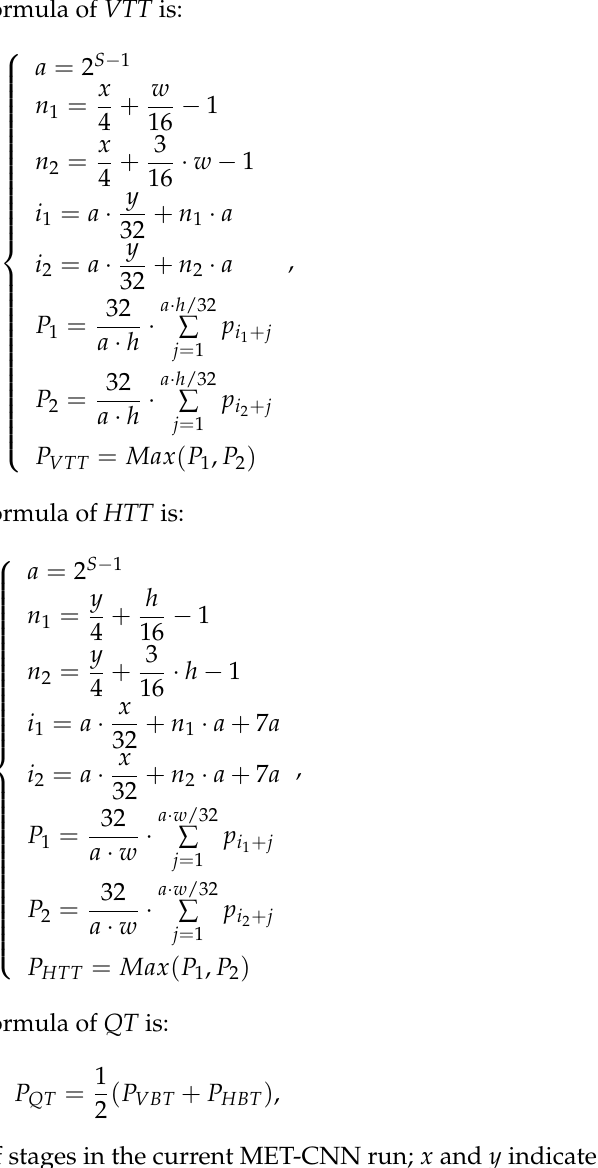
algorithm with different threshold formulas to perform coding tests on the VVC standard test sequence ParkRunning3 under the coding environments of QP = 22, 27, 32, and 37. The algorithm performance is listed under different thresholds in Table 2. The performance